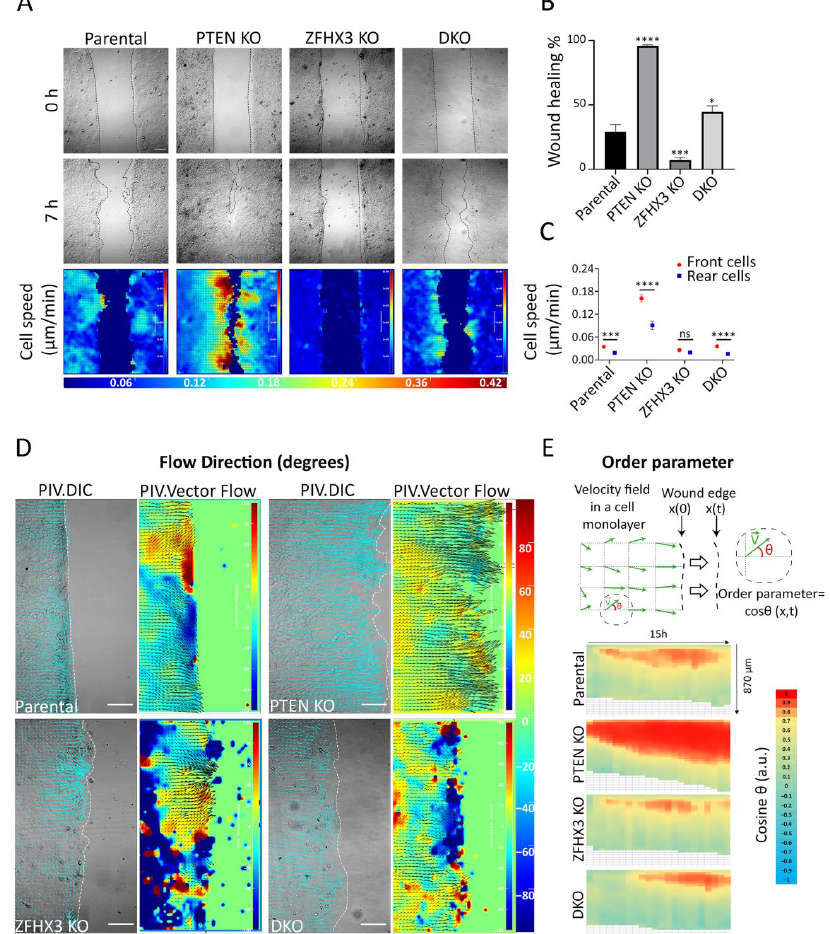
Figure 4. Wound healing of gene-edited MCF10A cell lines. ( A ) Heat map representation of cell speed after 7 h of migration. Scale bars: 100 μm. ( B ) Wound closure percentage after 7 h. ( C ) Cell speed; for front and rear cells in a monolayer. ( D ) Heat map representation of cell angles relative to the wound extracted from PIV analysis along the edge at the last hour of migration. Scale bars: 100 μm. ( E ) Local parameter order. Heat map of the average cosine value of the angle of displacement